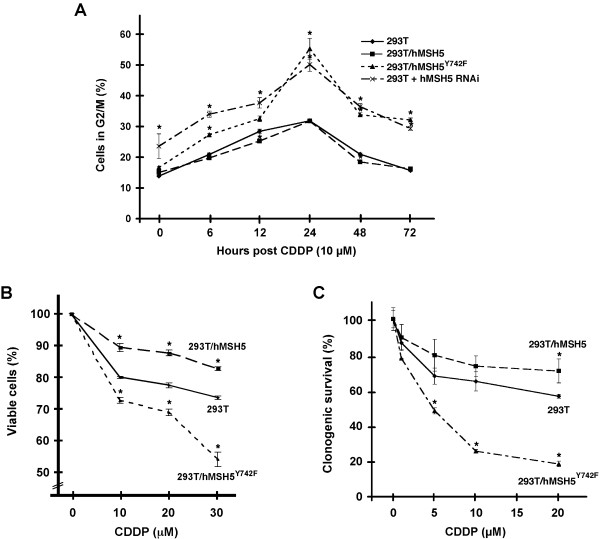
The effects of hMSH5 deficiency on cisplatin sensitivity. (A) hMSH5 deficiency increased G2/M arrest in response to cisplatin treatment. 293T, 293T/f-hMSH5, 293T/f-hMSH5Y742F, and 293T hMSH5 RNAi cells (hMSH5-silenced 293T cells) were treated with cisplatin for 2 hrs, and were used for the cell cycle analysis at indicated time points. Percentages of G2/M cells were determined using FlowJo (Dean-Jett model). (B) MTT assays were performed to determine the proliferation of 293T, 293T/f-hMSH5 and 293T/hMSH5Y742F cells in response to cisplatin treatment. (C) Clonogenic survival analysis of 293T, 293T/f-hMSH5, and 293T/f-hMSH5Y742F cells treated with different doses of cisplatin. Cells were treated with indicated doses for 1 hr and maintained in culture for 14 days to allow colony formation. Error bars represent standard deviations from the means of three independent measurements. Asterisks denote p < 0.05 by Student t-test.